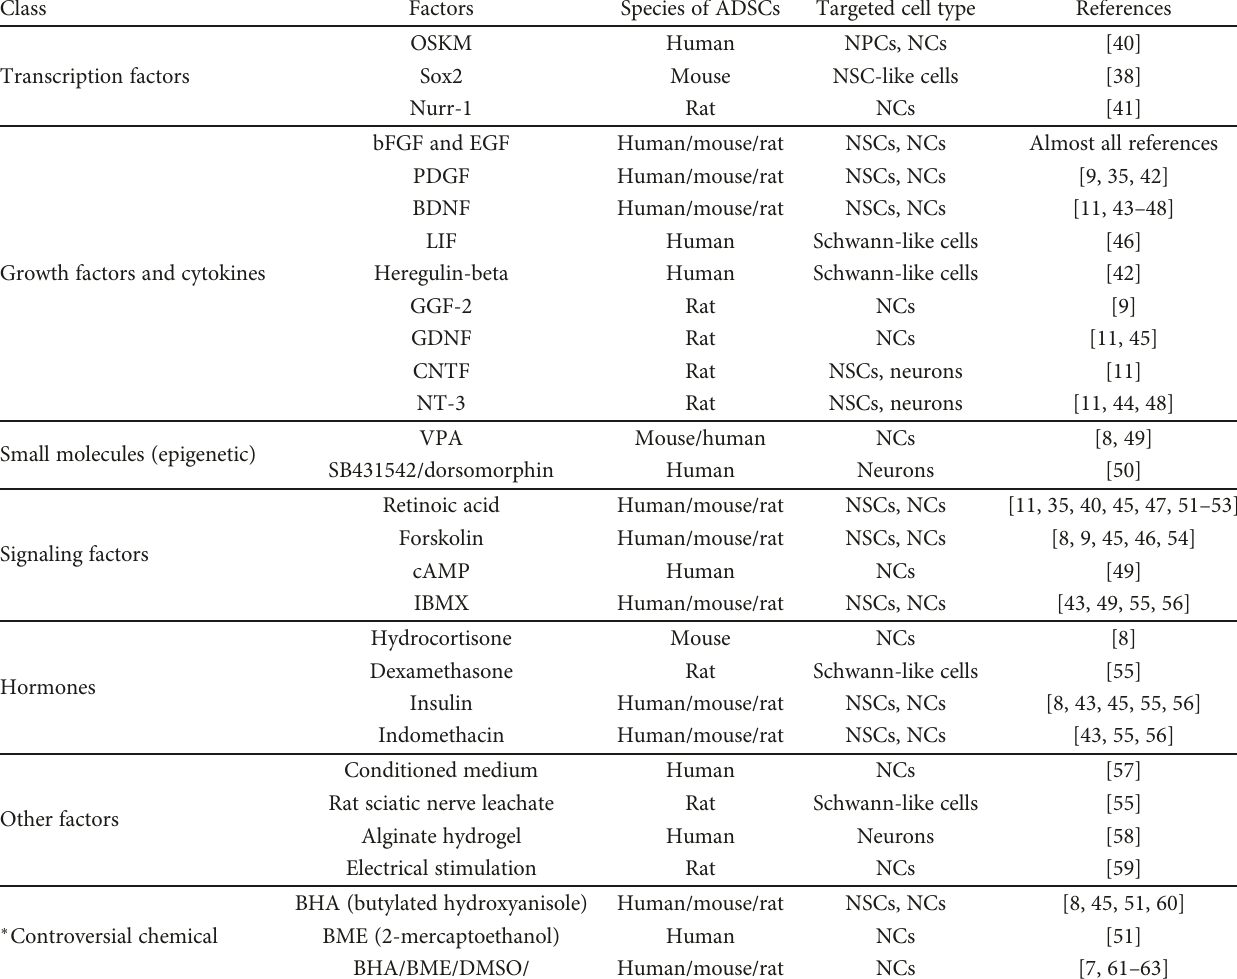
Table 2: List of protocols inducing the transdi ff erentiation of ADSCs into neural